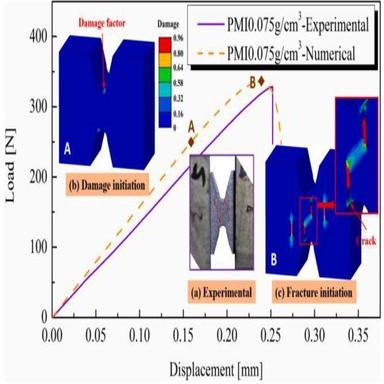
Comparison of the numerical and experimental load-displacement response and failure mode for PMI foam material under combined tensionshear loading (45◦). Similar failure mode can be compared for the PMI foam under the combined tension-shear load and under pure shear. And the loaddisplacement response can also be well predicted.